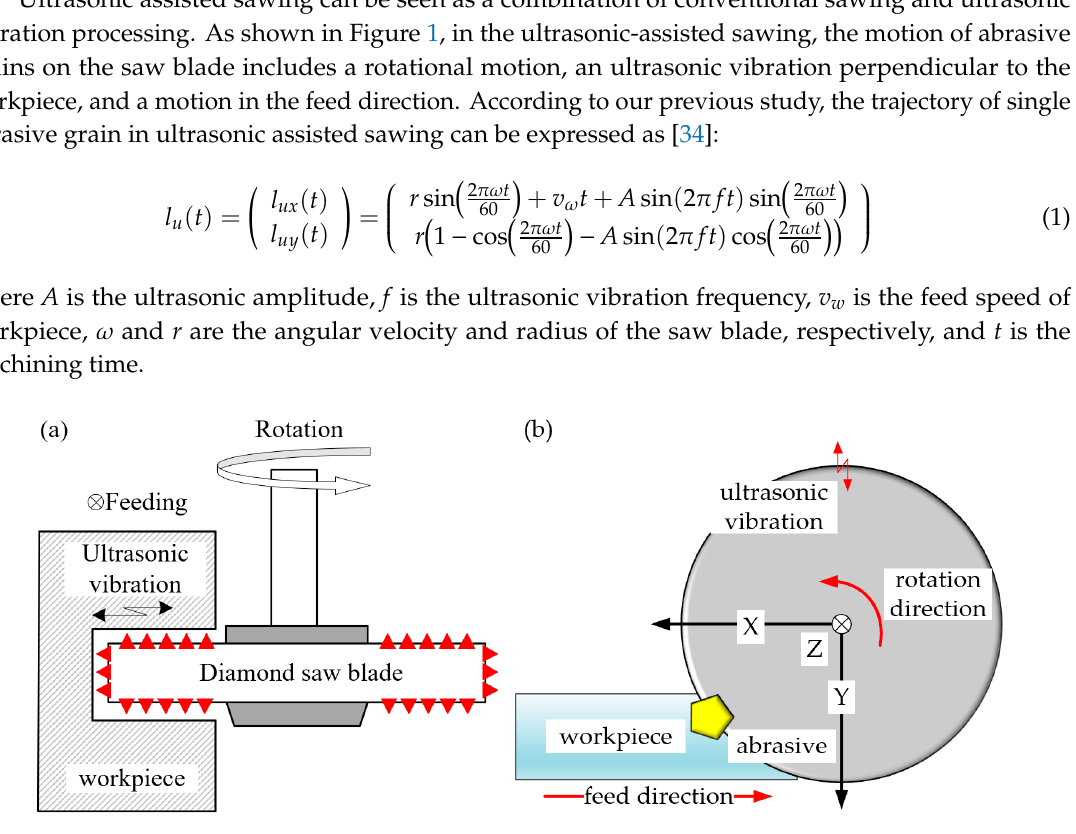
Figure 1. Illustration of ultrasonic-assisted sawing. ( a ) basic configuration; ( b ) the motion of single abrasive